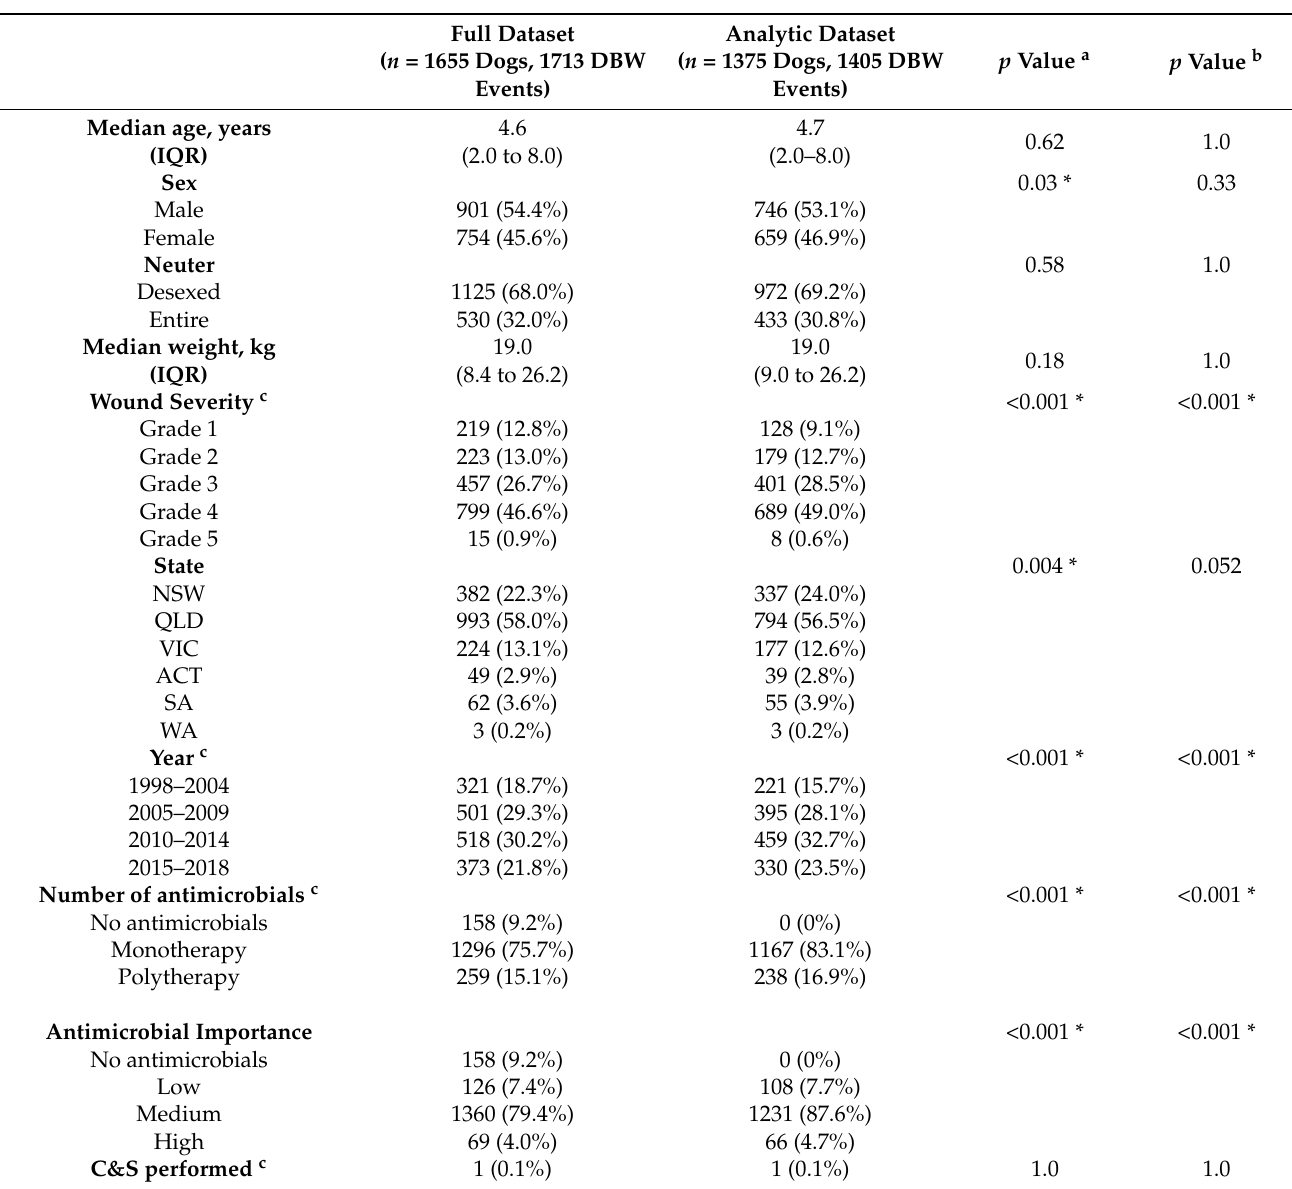
Table 1. Comparison of baseline patient characteristics of initial versus analytic (removal of dogs that did not receive antimicrobials and incomplete records) datasets for dogs presenting with dog-to-dog bite wounds from 1998 to